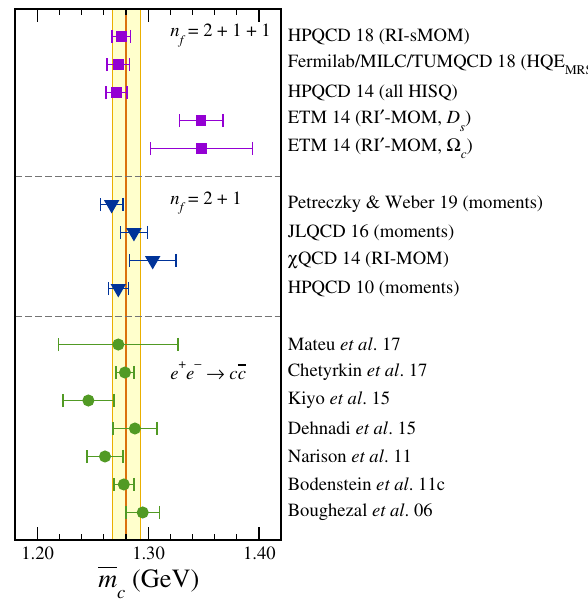
2 + 1 flavors of sea quark [262–266]; circles denote results extracted = m ( m ) from e + e − collisions near Q ¯ Q threshold [267–279]. The vertical band c c , MS c , MS shows the FLAG 2019 average for 2 + 1 + 1 sea flavors. Note that 2 + 1- flavor calculations are in rough (good) agreement for bottom (charm)